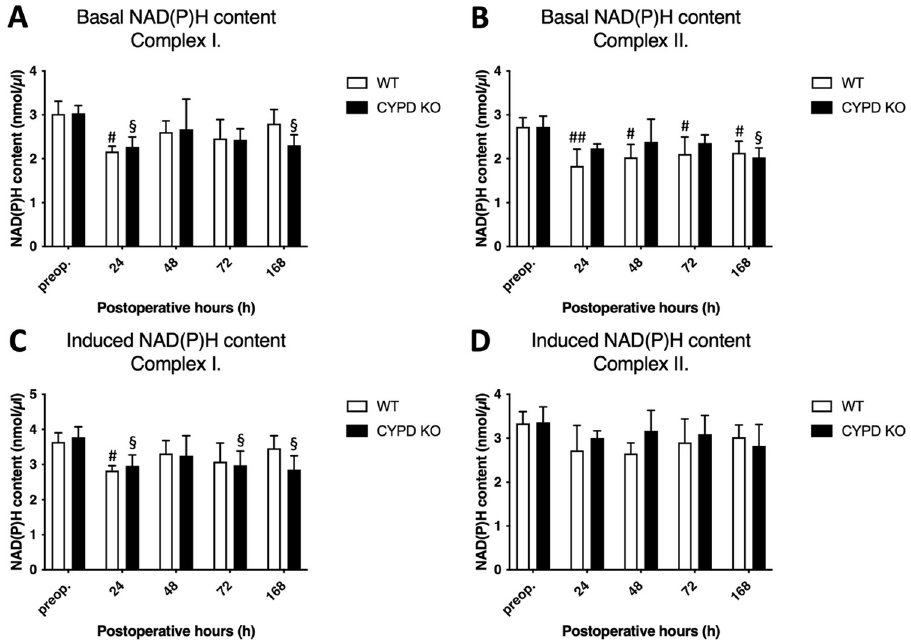
Fig 3. Changes in reduced nicotinamide adenine dinucleotide (phosphate) (NAD(P)H) content. Basal (A and B) and substrate (complex I: Glutamate-malate complex II: Succinate) induced (C and D) NAD(P)H preoperatively (preop., 0 h), and at 24 h, 48 h, 72 h, and 168 h after Associating Liver Partition and Portal vein ligation for Staged hepatectomy (ALPPS) (N = 6 per time point per group). � P < 0.050, �� P < 0.0010 versus wild type (WT); # P < 0.050, ## P < 0.001 WT versus corresponding controls (preop.); § P < 0.050, §§ P < 0.0010 CypD KO versus corresponding controls (preop.). Statistical analysis was performed with a two-way ANOVA and Tukey’s post hoc test.